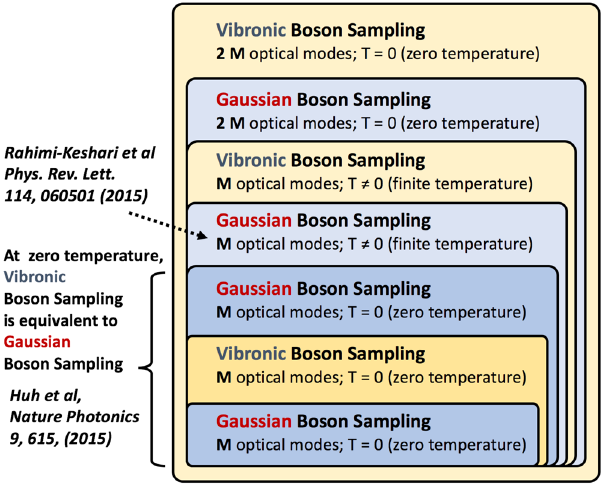
Figure 4. Hierarchy of Gaussian Boson Sampling. The Hierarchy of Gaussian Boson Samplings are structured according to the temperature and the size of the problem. For the same temperature and same number of modes, Gaussian Boson Sampling 15 is always a special case of Vibronic Boson Sampling, except at zero temperature, the two classes are the same as proved in ref. 16. In this work, we prove that Vibronic Boson Sampling at finite temperatures can be transformed into Gaussian Boson Sampling by doubling the optical